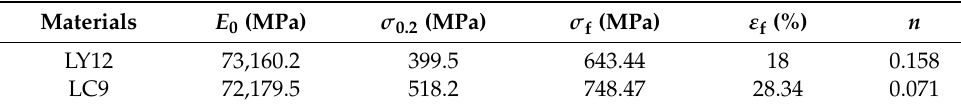
Table 1. The mechanical parameters for two materials